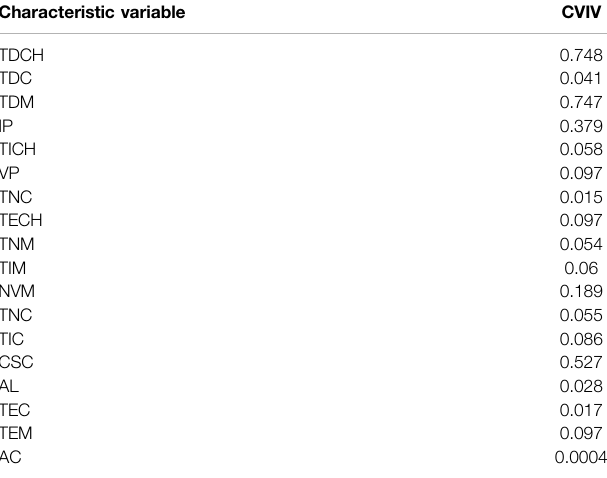
TABLE 1 | The CVIV value of the telecom customer churn characteristic variables.